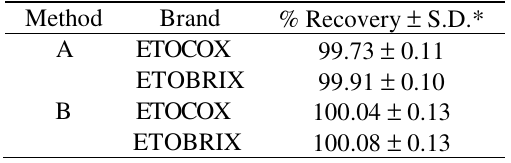
Table 4 . Drug recovery